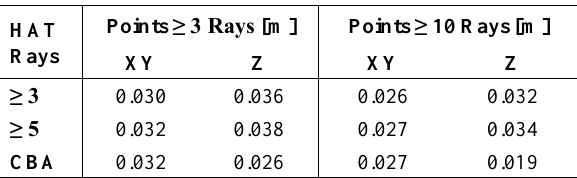
Table 3. Tie point differences (RMS) between the integrated AT and different hierarchical AT runs for the Heilbronn block.